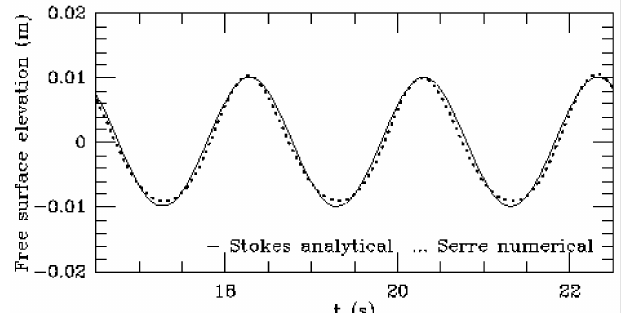
Figure 5. Periodic wave with 0.02 m height, 2.02 s period, and 3.73 m wavelength propagating in a channel of 0.40 m depth. Comparison of the analytical Stokes 2nd order solution in Equation (46) with numerical results in a gauge installed at x = 3.0 m ( α = 0.1308 and β = 0.20). Additionally, the numerical results are compared with the data recorded in probes installed at x = 10.5 m, x = 13.5 m, and x = 17.3 m (Figure 4); these comparisons are shown in Figure